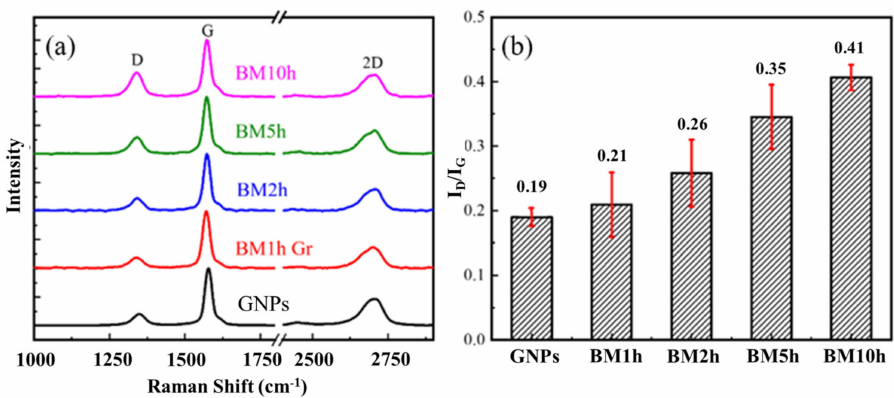
Figure 4. The influence of different ball milling time on graphene defect content. ( a ) Raman spectrum test results of graphene, ( b ) Raman spectrum I D / I G statistics of